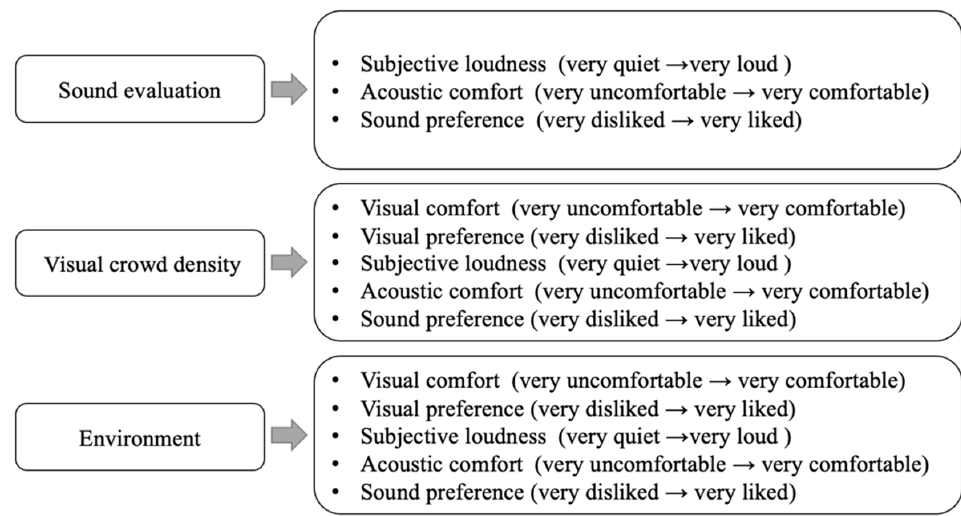
Figure 3. Contents of questionnaire and specific evaluation indicators.